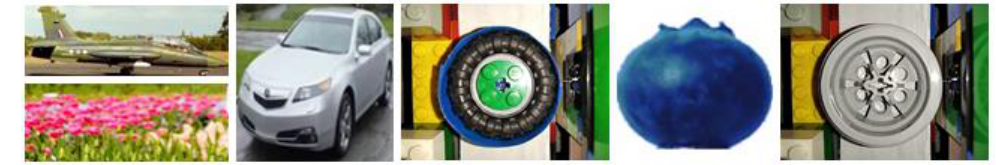
Figure 11. Different types of images found in the test dataset.